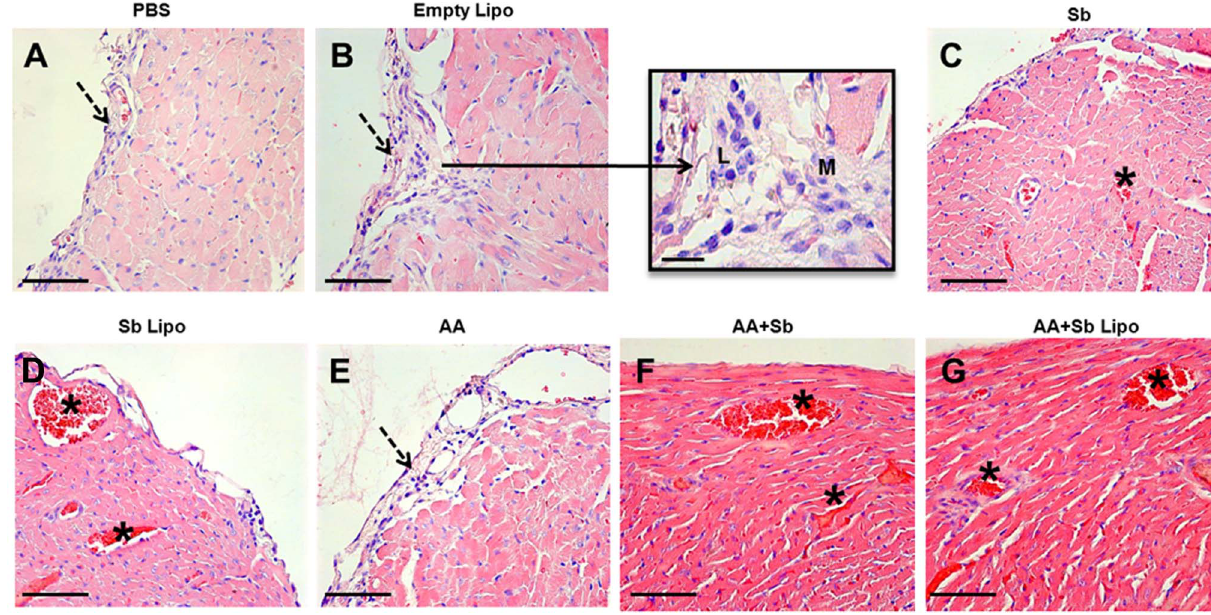
Figure 5. Histopathological analyses of the heart from L.infantum infected mice submitted to different treatment regimens. (A) Phosphate-buffered saline (PBS). (B) Empty liposomes (Empty Lipo). (C) Trivalent antimony (Sb). (D) Antimony entrapped liposomes (Sb Lipo). (E) Ascorbic acid (AA). (F) Ascorbic acid in association with antimony (AA + Sb). (G) Ascorbic acid in association with antimony entrapped liposomes (AA + Sb Lipo). Bar =50 m m. Insert =25 m m, representing an inflammatory infiltrate of lymphocytes (L) and macrophages (M). Dashed arrow = subendocardial inflammatory infiltrate composed of mononuclear cells. * Active hyperemia.